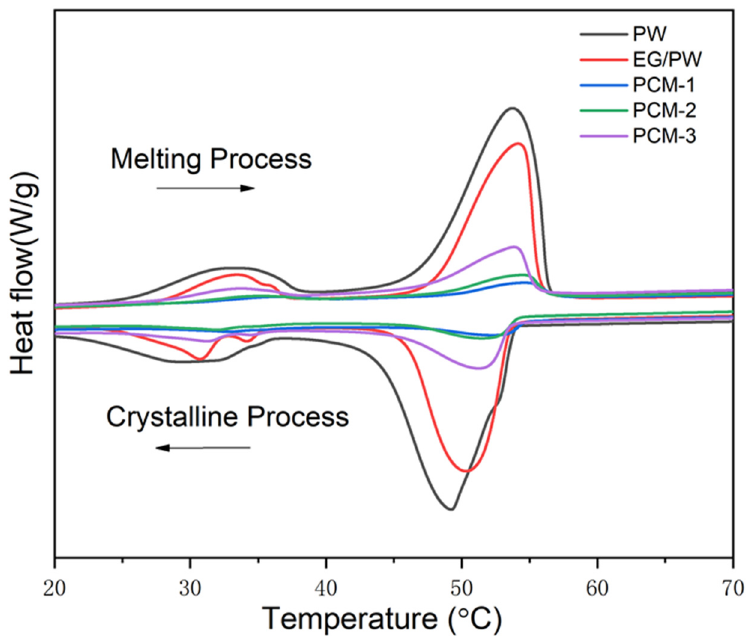
Figure 5. DSC cures of the pure PW, EG / PW and EG / PW / SR